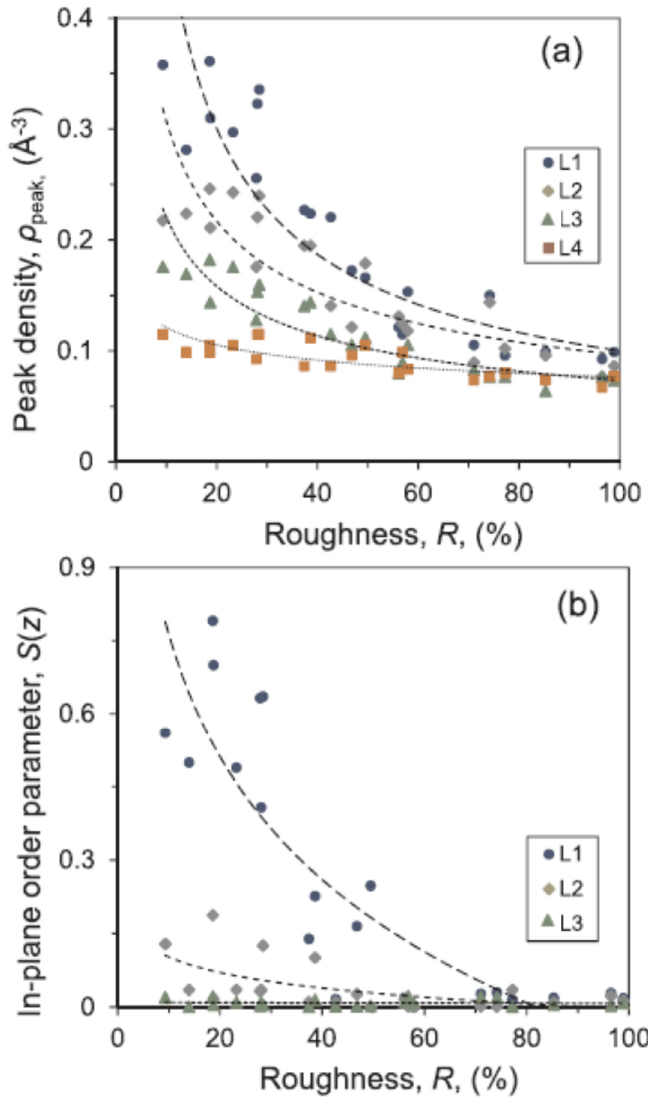
Figure 17. Effect of surface roughness of crystalline substrate on prenucleation [25]. ( a ) ρ p ( z ) and ( b ) S ( z ) of L1, L2, L3, and L4 in liquid Al adjacent to a crystalline substrate as a function of surface roughness, R , equilibrated at 1000 K. The dashed lines are the fitting line for each data set. Both the layering and in-plane ordering adjacent to the interface deteriorate with increasing surface roughness, R . (Reprinted with permission from Ref. [25]. 2022, Elsevier.)